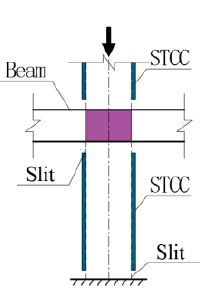
Figure 1. STCC and CFST columns. ( a ) STCC; ( b ) CFST.